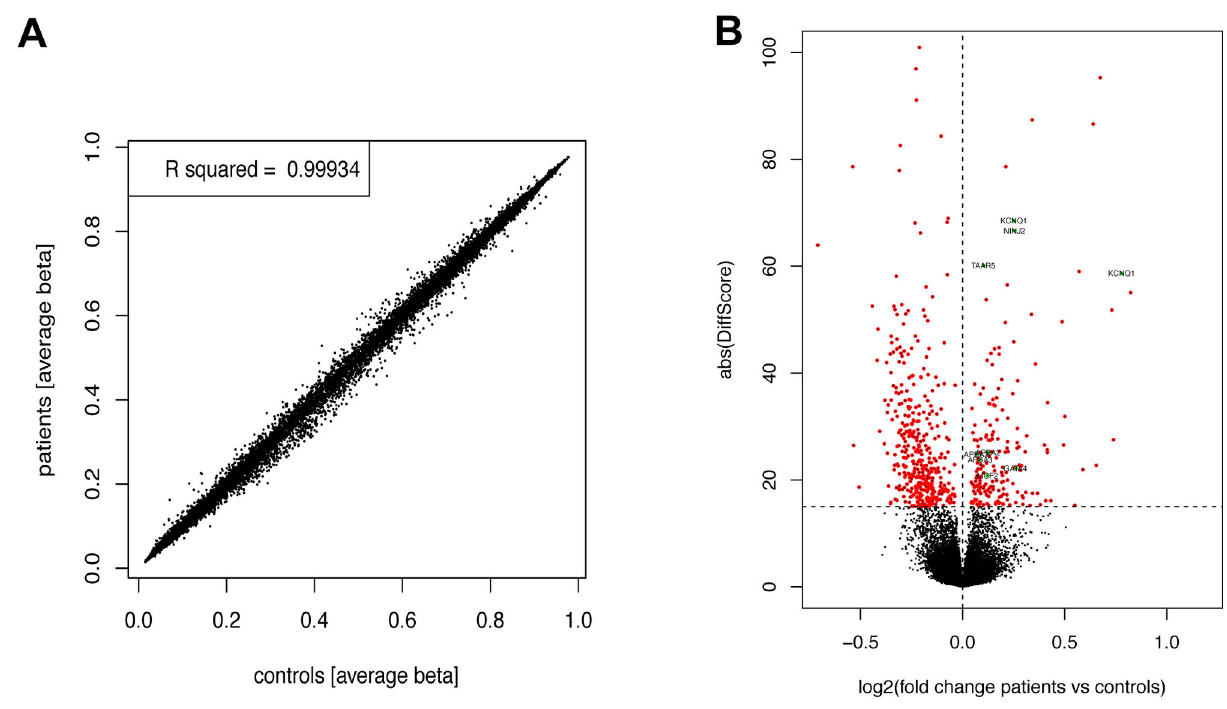
Figure 1. Methylation rate at 27,578 individual CpG target sites from 24 female BPD patients and 11 female control samples. Scatter plot of pairwise comparison between female BPD patients and controls (A) and volcano plot for visualization of differentially methylated probes between both groups (B). Methylation levels of 27,578 CpGs sites were revealed by HumanMethylation27 bead chip technology and the average beta-value (beta) and the absolute DiffScore for patients and control groups was determined. Beta is the ratio of the methylated signal to the sum of unmethylated and methylated signal. The DiffScore is a transformation of the p-value that provides directionality to the p-value based on the difference between the average signal in the reference group vs. the comparison group. The formula is: DiffScore = 10*sgn(µcond-µref)*log10p; For a p-value of 0.05 the DiffScore is ~13. 259 CpGs exhibited a significantly higher DiffScore (≥13). Analyzed CpGs of APBA2, APBA3, GATA4, HLCS, KCNQ1, MCF2, NINJ2 and TAAR5 are